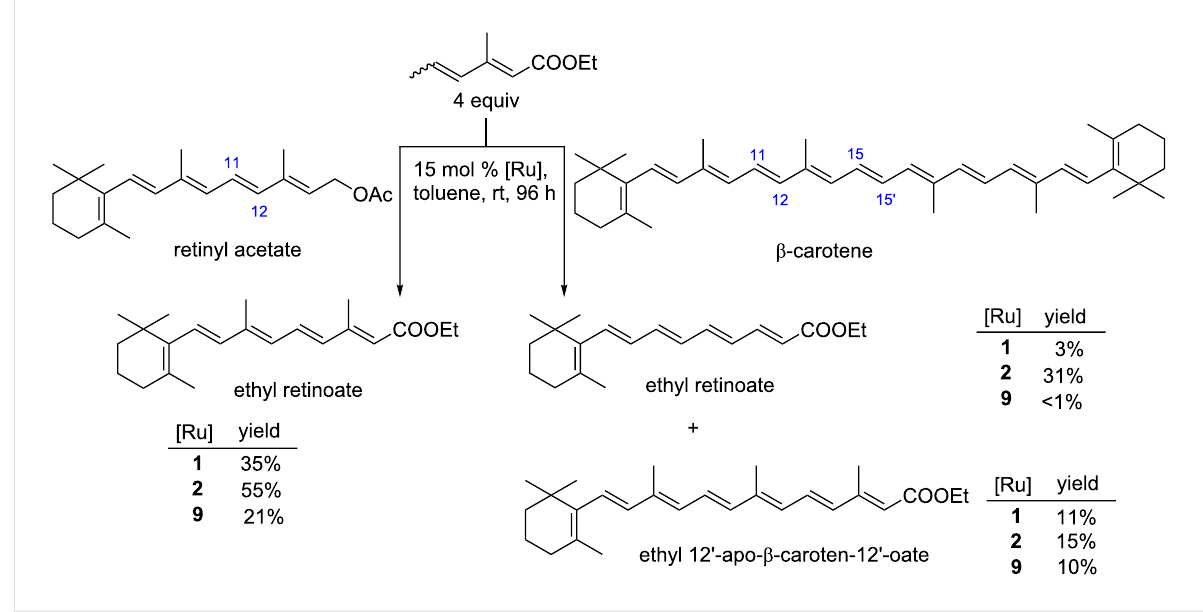
Scheme 4: CM reaction of β -carotene and retinyl acetate with ethyl (2 E ,4 Z / E )-3-methylhexa-2,4-dienoate. Reaction conditions: diene (4 equiv, 0.325 M), alkene (1 eqiuv, 0.08 M). Yield was obtained by quantative HPLC analysis. Yields were calculated in relation to polyene (retinyl acetate or β -carotene). In case of the β -carotene reaction, yields were divided by two due to the symmetry of the β -carotene molecule.